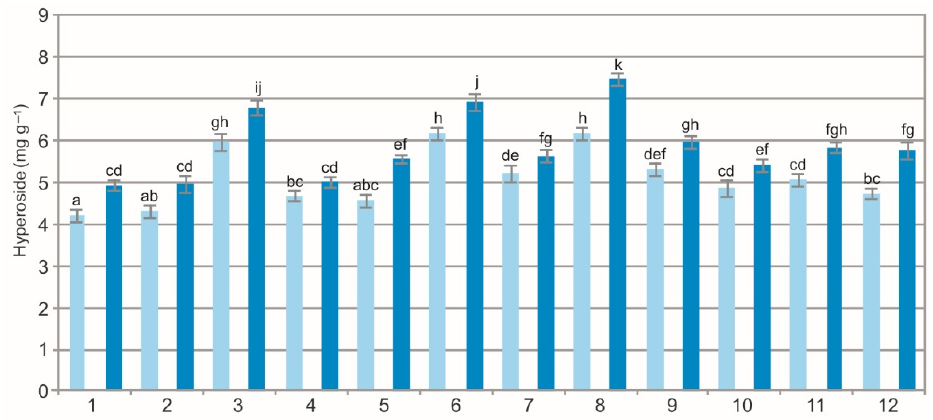
Figure 9. Hyperoside concentration in water (light blue) and ethanol (dark blue) leaf extracts from bearberry plants in different populations. The values designated by the different letters are significantly different ( p < 0.05).